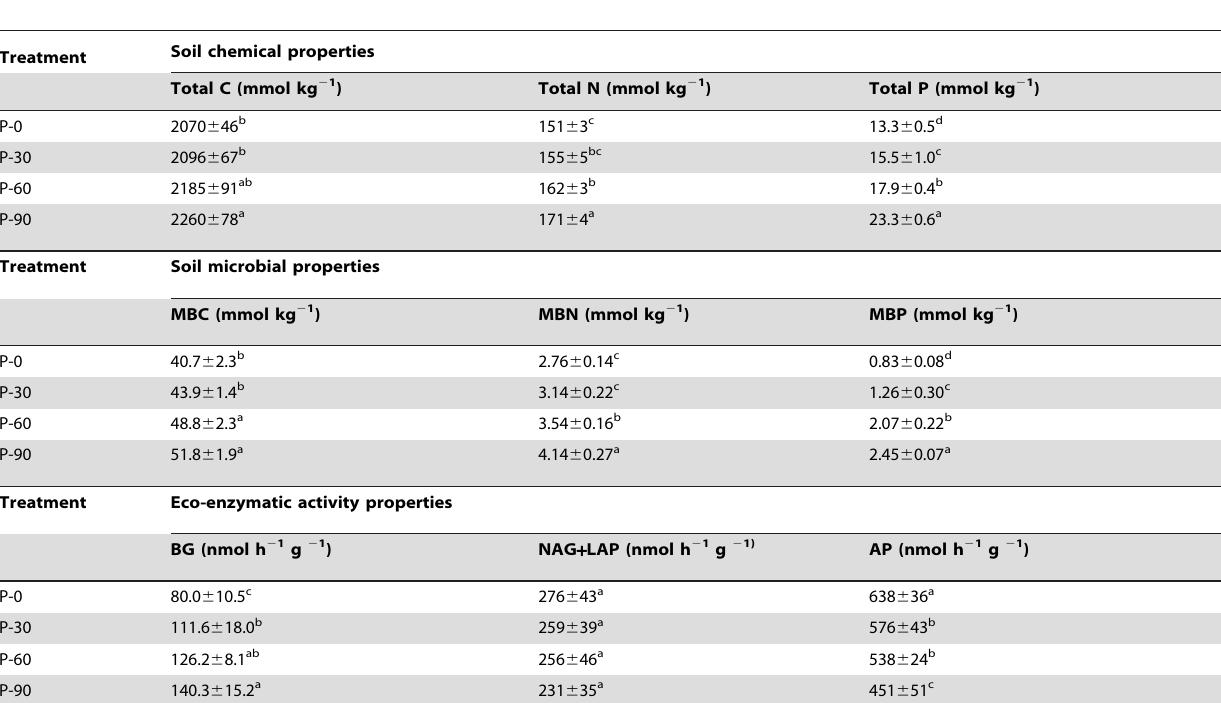
Table 1. Soil chemical, microbial, and eco-enzymatic properties in the tested paddy field after 5 years of phosphorus application.